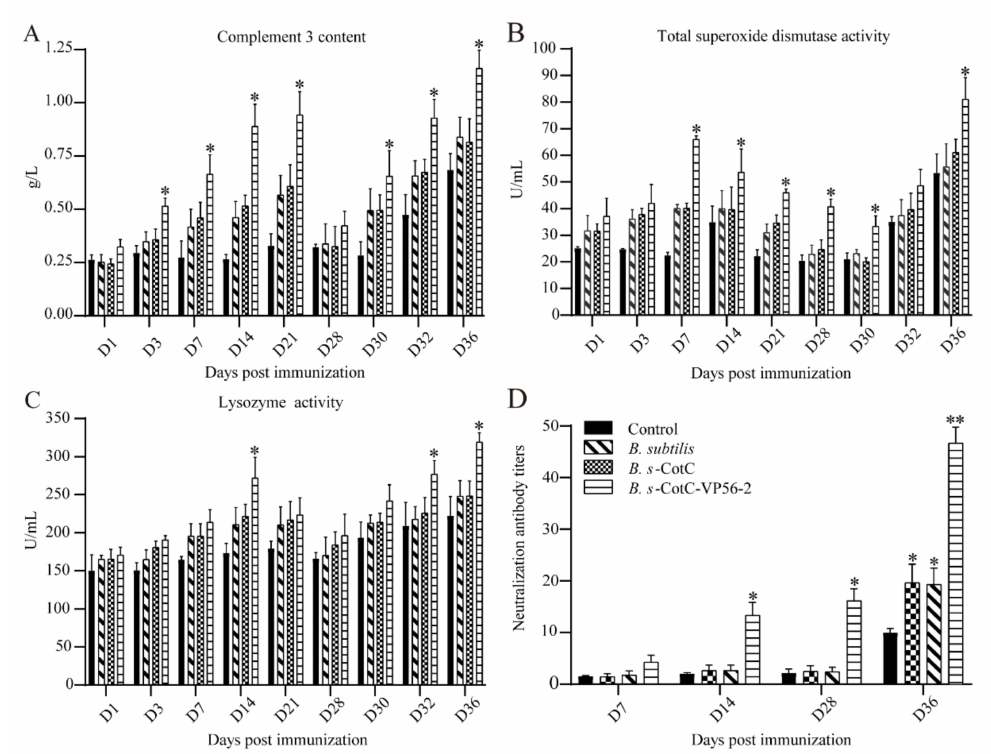
Figure 5. Serum innate immunity index. Complement C3 ( A ), lysozyme ( B ) and total superoxide dismutase ( C ) were measured using commercial kits (China Nanjing Jiancheng Institute of Bioengi- neering). Data are presented as the means ± SD. Values that were significantly different from the control are indicated by asterisks. The neutralization assay of anti-GCRV II serum in vitro. ( D ) The reciprocal of the highest serum dilution needed to prevent cytopathic disease in each experimental group and at different time-points. Data were presented as means ± SD ( n = 4). (One-way ANOVA * p < 0.05, ** p <